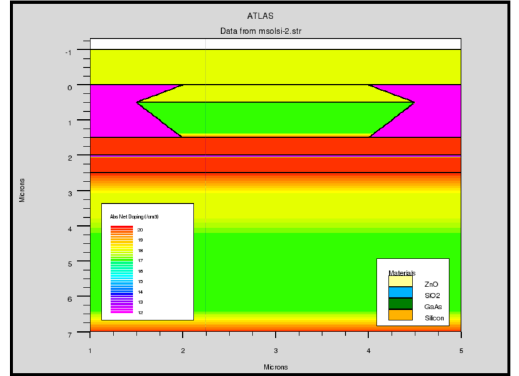
Fig. 5. Calculated band structure of the MultiSolSi structure showing the high bandgap window on the left, and succeeding GaAs and Si solar cells connected in series by a